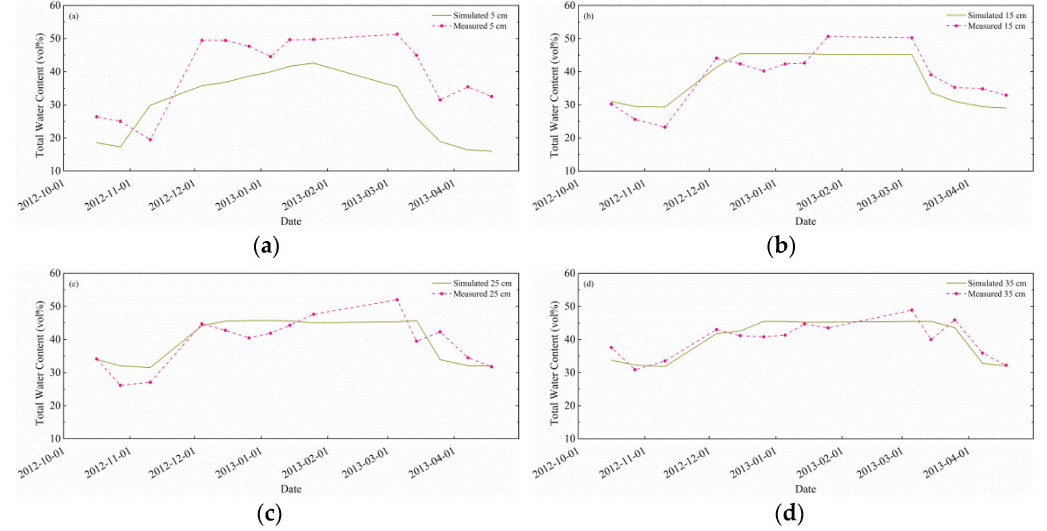
Figure 4. Comparison of the simulated and measured total water contents for different depths. The dark yellow line shows the simulated total water content at various depths; the magenta line with circles denotes the measured total water content at various